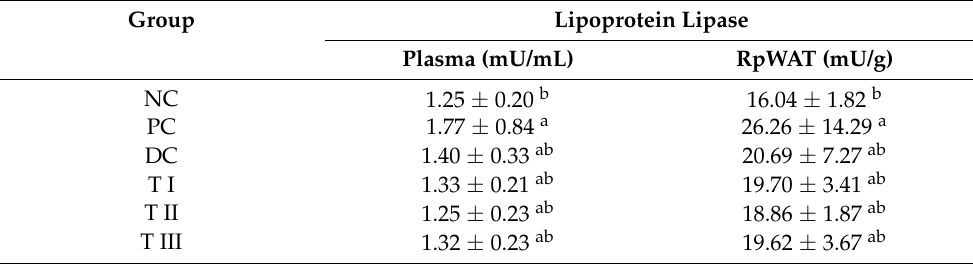
Table 5. Anti-obesity effect of E. tapos shell extract on lipoprotein lipase (LPL) activity. Group